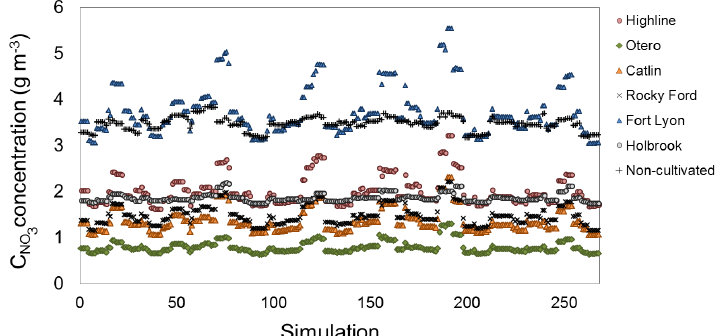
Figure 7. Spatiotemporal average value of C NO in groundwater during the 2006–2009 simulation period for each canal command area for 3 each of the 280 UZF-RT3D model simulations. The spatiotemporal average for the non-cultivated areas also is shown (small black crosses). factors on C NO in layer 1 (top 0.5 m of the root zone), C NO 3